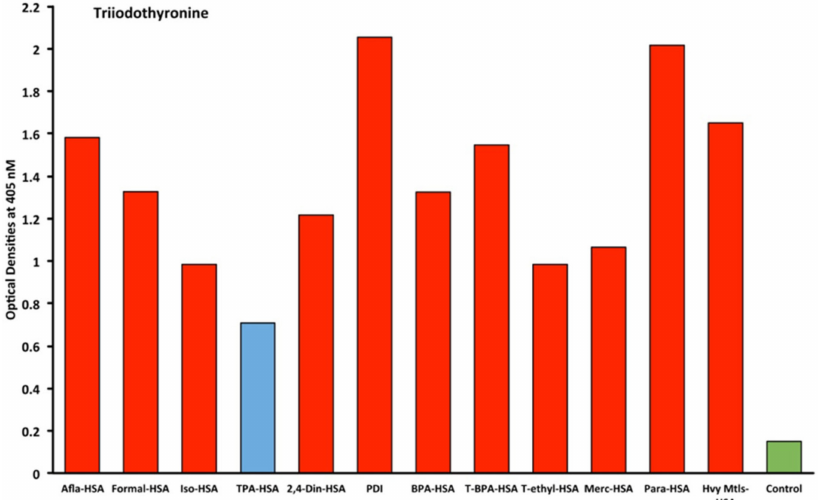
Figure 3. Reaction of monoclonal triiodothyronine antibodies with di ff erent chemicals bound to human serum albumin. The antigens in red represent OD levels that are above the control and also 1 standard deviation above the mean of all 84 single measurements of chemicals bound to HSA. The antigens in blue are less than 1 standard deviation above the mean. The control is in